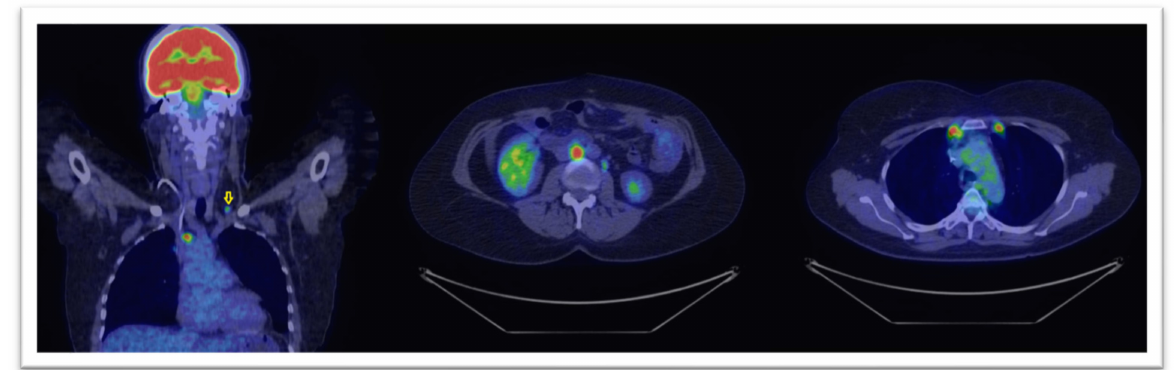
Figure 4. 18F-FDG PET-CT scan with coronal (left image) and axial views (central and right) reveal intense tracer uptake in lumbo-aortic and mediastinal lymph nodes and also in a left supraclavicular one (marked with yellow arrow), in a patient with a CA-125 level of 280 U/mL. The lymphatic spread was suggestive for unexpected progressive disease.